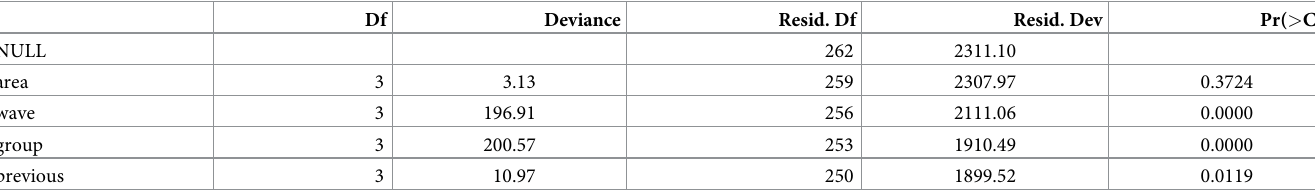
Table 21. ANOVA table for git commits.